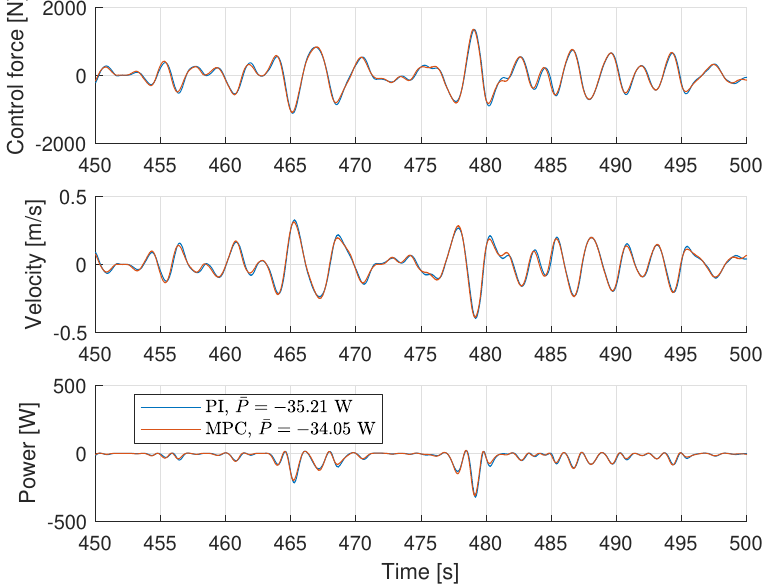
Figure 6. Time history of control forces, velocities, and power captures obtained by PI controller and